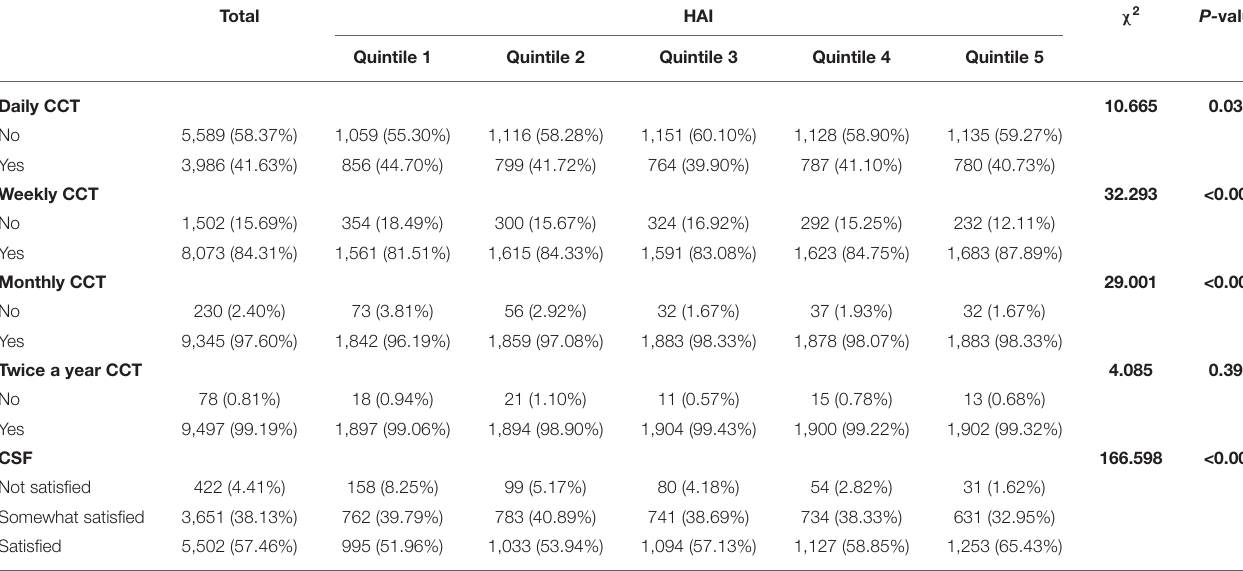
TABLE 1 | Distribution of healthy aging across contact with children (CCT) and satisfaction in parents aged 45 and older, [ N (%)]. Total HAI χ 2 P- value Quintile 1 Quintile 2 Quintile 3 Quintile 4 Quintile 5